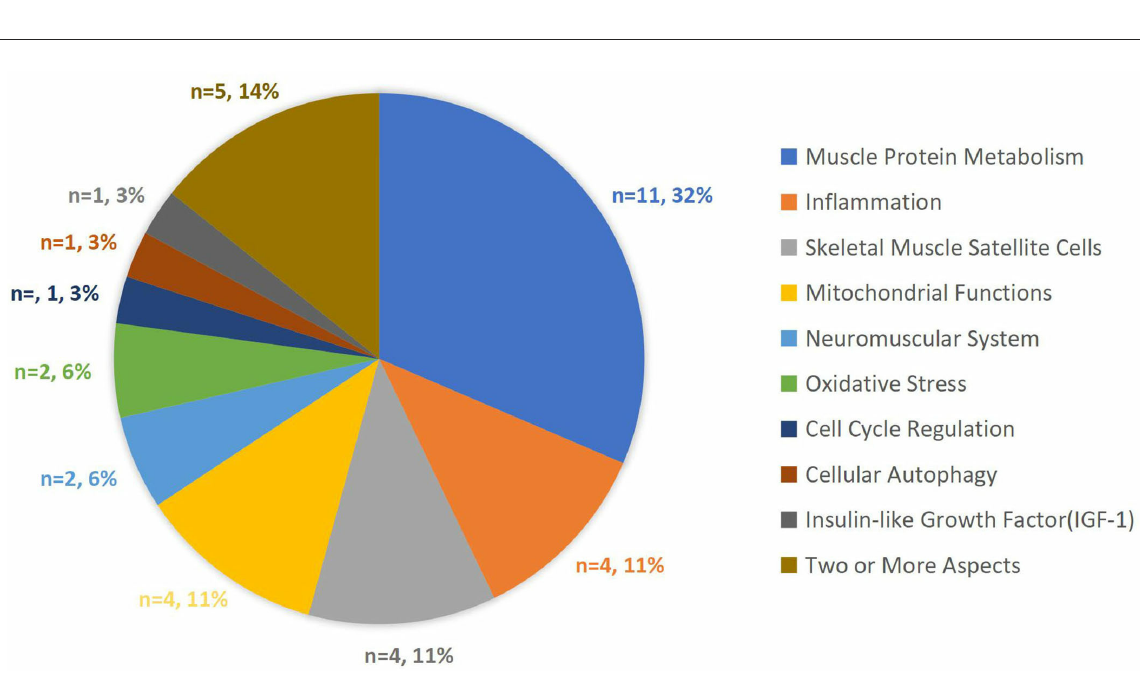
FIGURE5 The proportion of the research orientations of the articles that focused on cellular/molecular